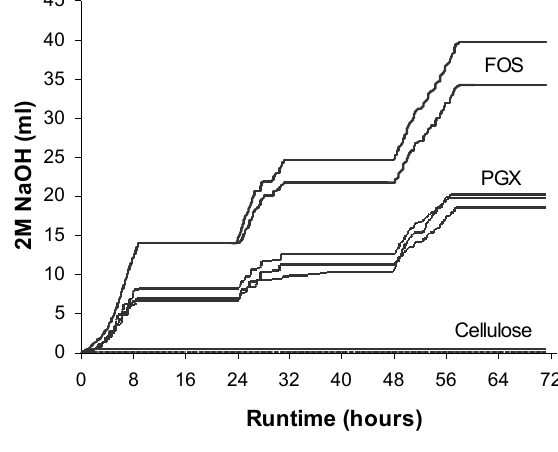
1. Sodium hydroxide usage during multiple TIM-2 runs over time for fructooligosaccharide (FOS), PolyGlycopleX (PGX) and cellulose. Values at the start of the test period were set to zero. Individual runs are shown where n = 2 for FOS and cellulose and n = 3 for